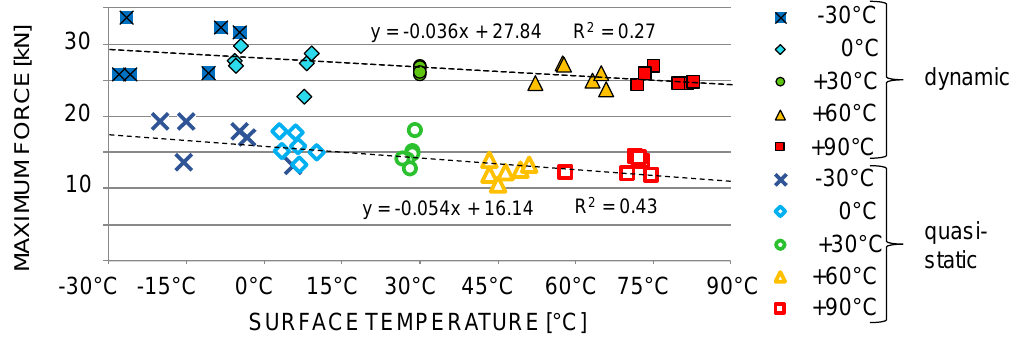
Figure 10. Scatter-plot of the dynamic and quasi-static maximum force over temperature.